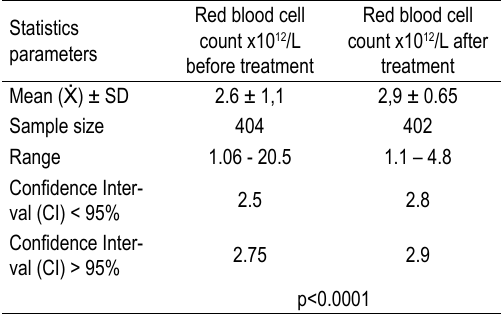
Table 6. changes of white blood cells count before and after transfusion treatment in patients with Gastro intestinal